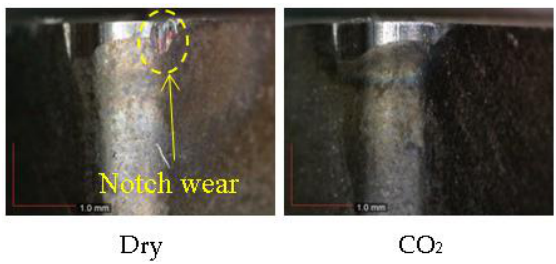
Figure 6. Images of notch wear occurring after 500 mm cutting length.